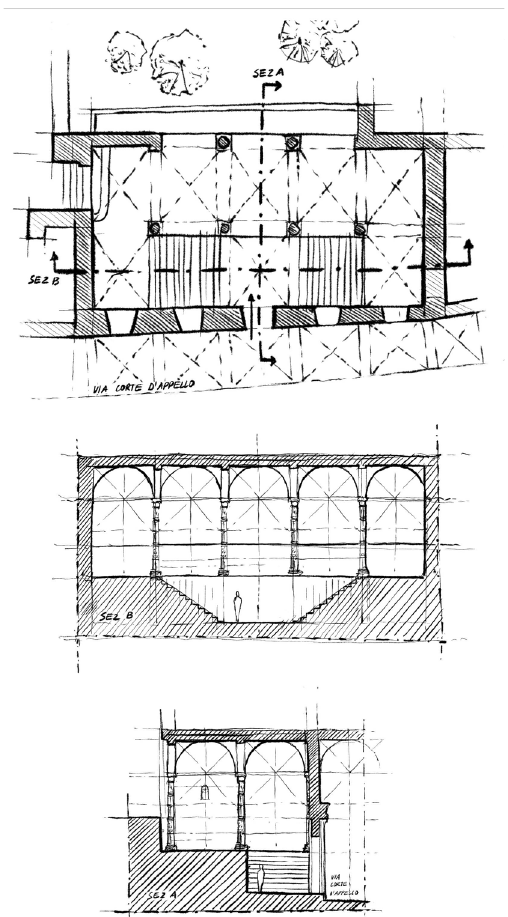
Figure 5 . Visual surveys of the